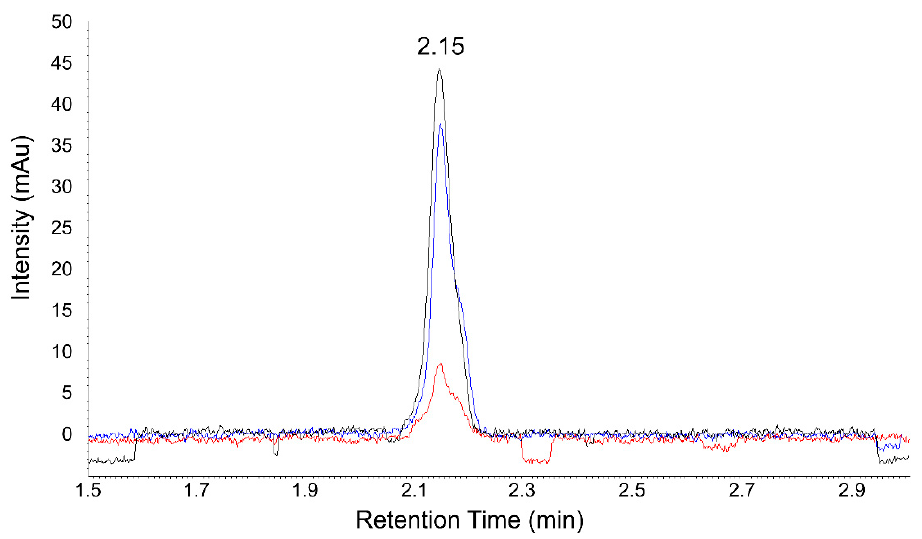
Figure 6. Example of a chromatogram of the DPPH radical signal (black line), DPPH radical signal after reaction with D -pinitol from carob (blue line), and DPPH radical signal after reaction with a mixture of D -pinitol from carob and glutathione (red line).